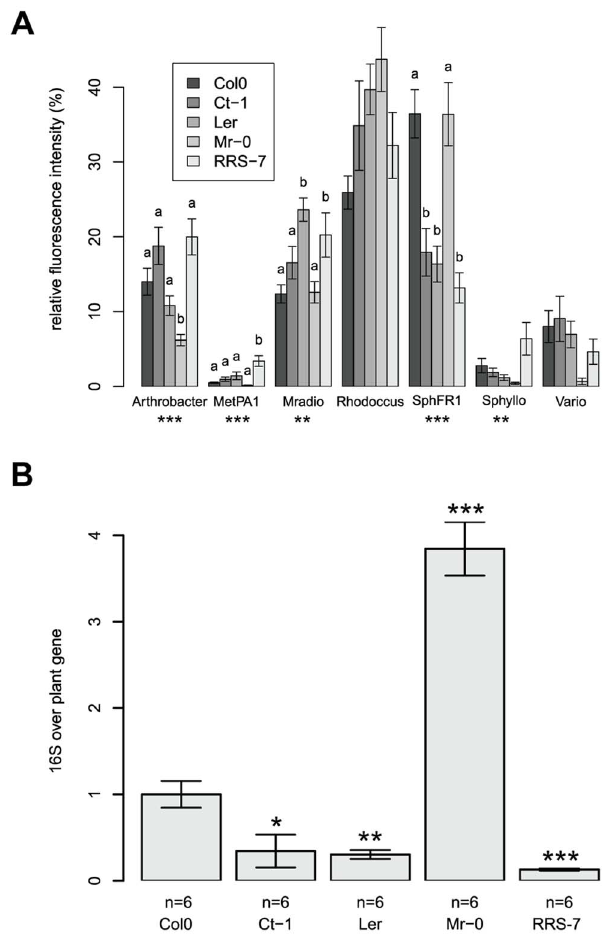
Figure 5. Natural variation in the host has an effect on its associated bacterial communities. (a) Community composition determined by ARISA. Average relative fluorescence intensity ( 6 s.e.m). For abbreviations see Figure 3. Letters indicate a significant effect of the genotype compared to Col-0 ( P , 0.05, Dunnet’s test). (b) 16S rRNA gene copy number. Asterisks indicate a significant effect of genotype compared to Col-0 (*, P , 0.05; **, P , 0.01; ***, P , 0.001; Bonferroni- adjusted P values). There were 6 DNA pools from five plants for each genotype. These experiments were repeated in triplicate with similar